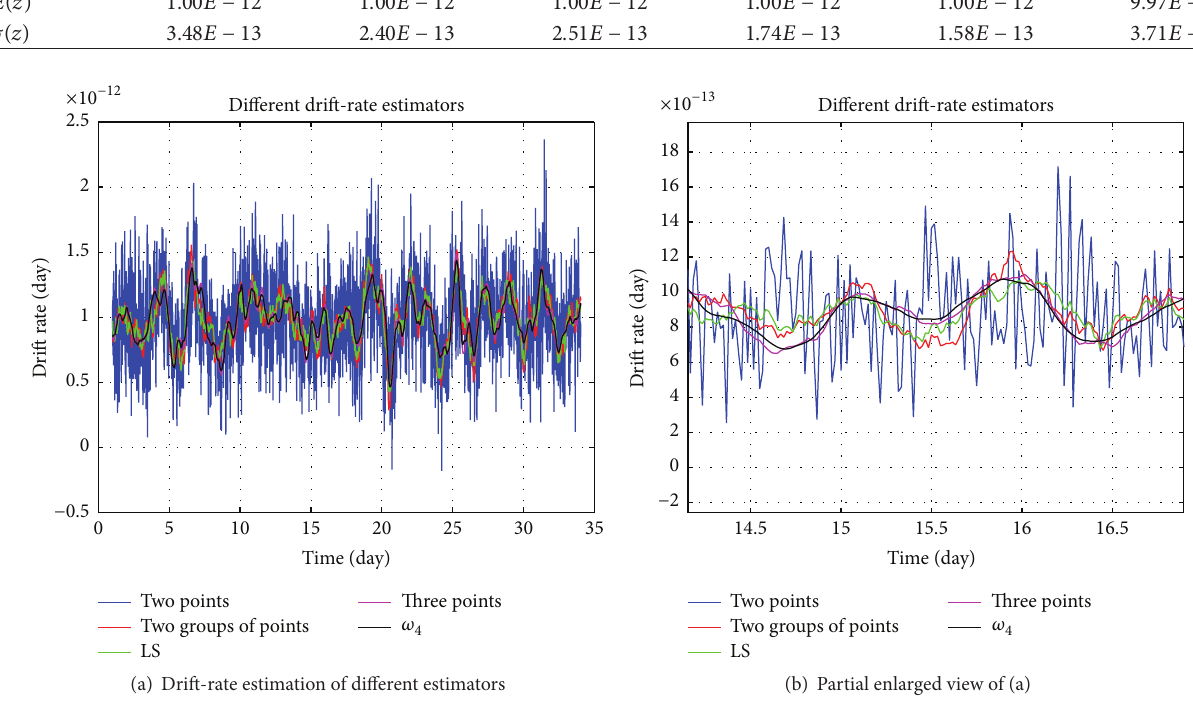
Figure 13: Comparison of different drift-rate estimators.